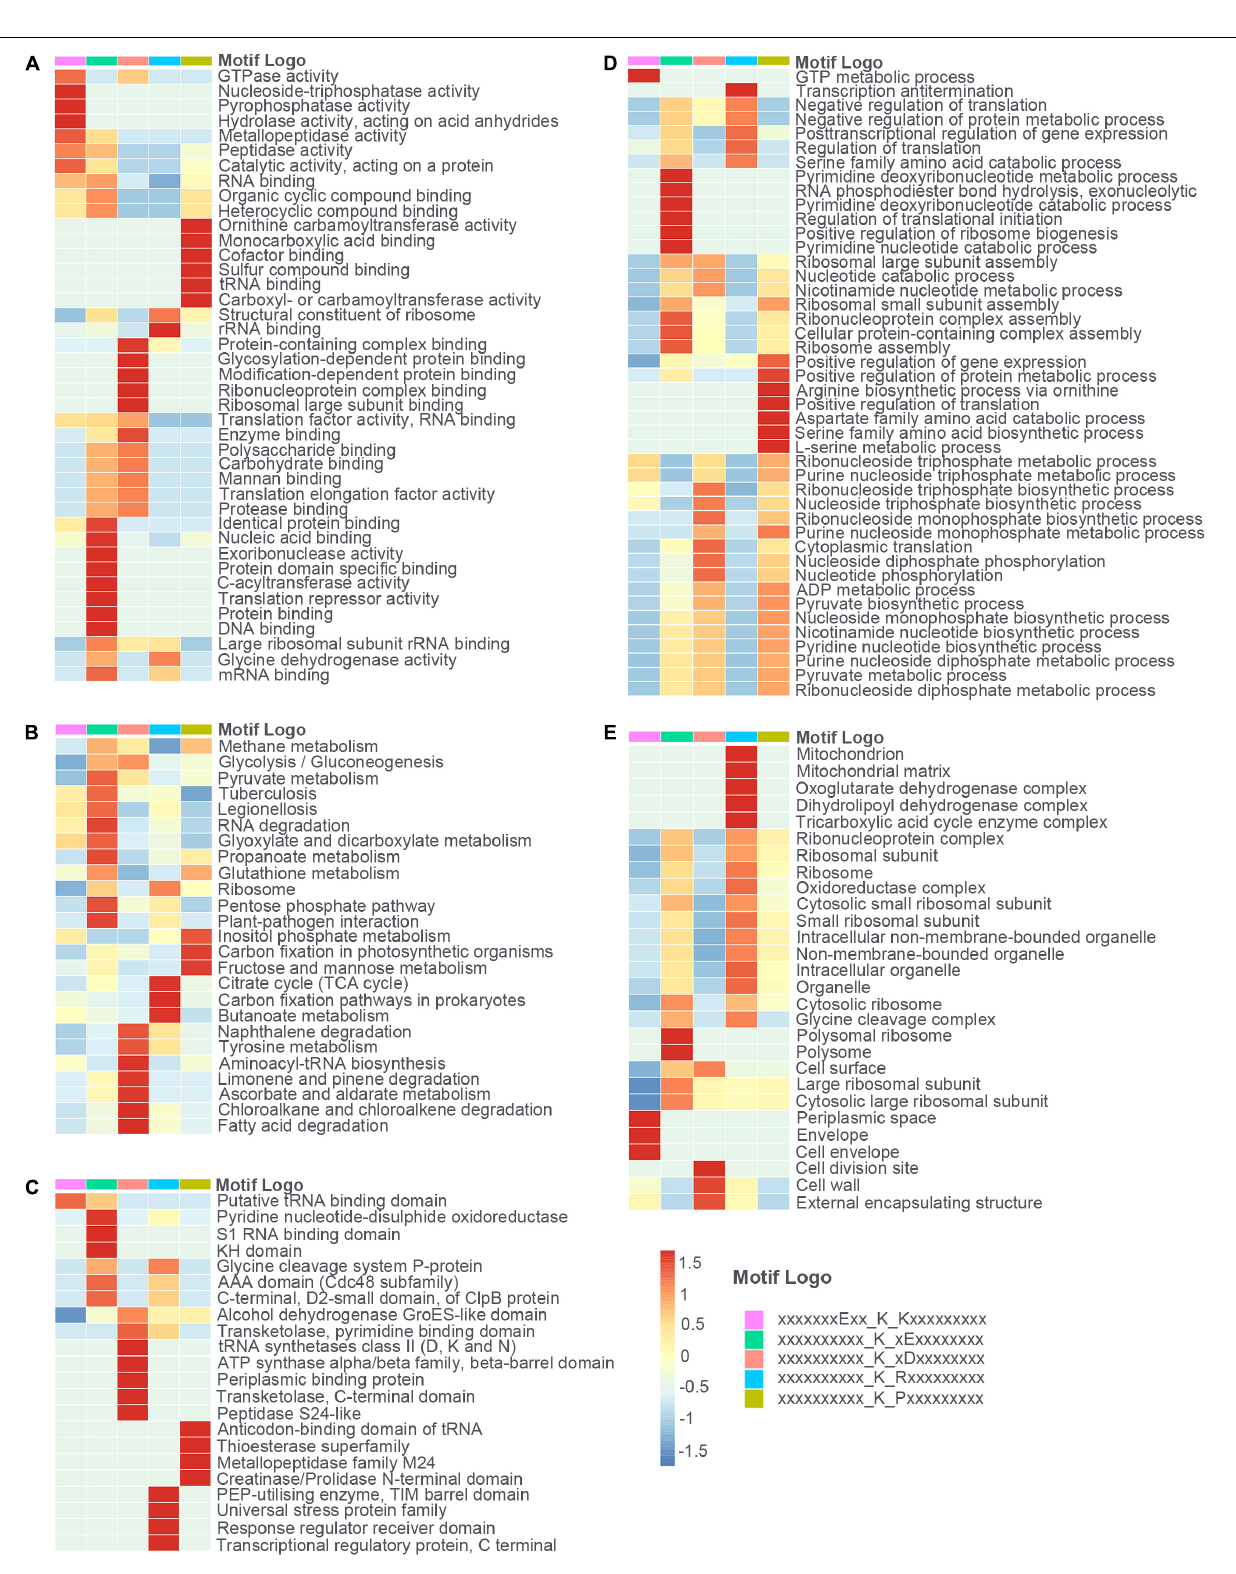
Frontiers in Microbiology |